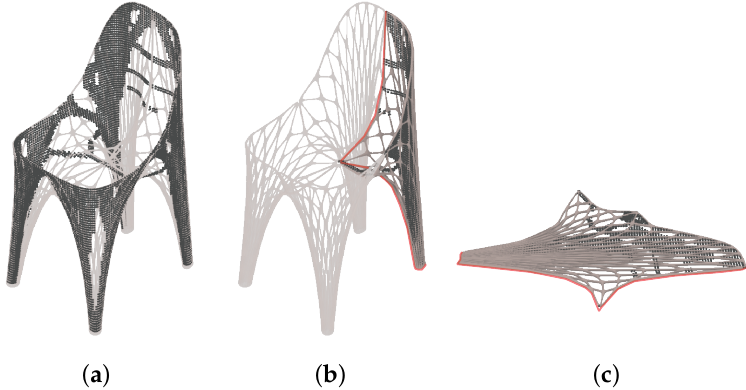
Figure 11. Topological optimisation workflow ( a ) Results of TO shown in black voxels. ( b ) One chair leg highlighted with seams shown in red. ( c ) Unrolled chair leg geometry with mapped points from TO for